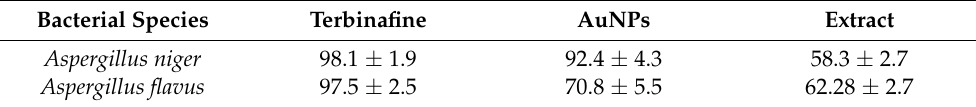
Table 4. Antifungal potential (zone of inhibition: mm) of extract and its mediated AuNPs. Bacterial Species